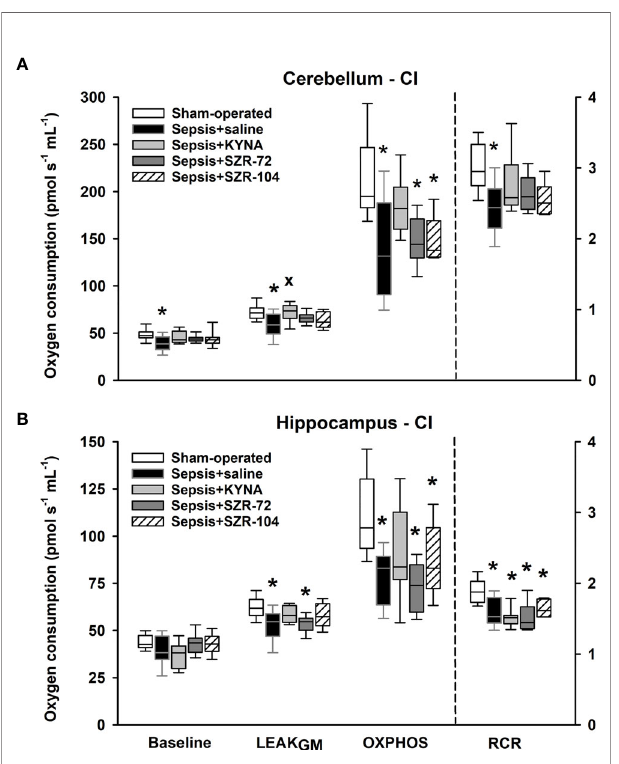
FIGURE 7 | Complex II-linked mitochondrial oxygen consumption in the cerebellum (A) and the hippocampus (B) in the sham-operated group and in the different sepsis groups treated with saline, KYNA, SZR-72 and SZR-104. The plots demonstrate the median (horizontal line in the box) and the 25 th (lower whisker) and 75 th (upper whisker) percentiles. One-way ANOVA, Holm – Sidak post-hoc test; * P < 0.05 vs . sham-operated group; x P < 0.05 vs . sepsis+saline